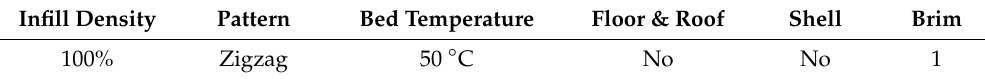
Table 3. Fixed parameters of carbon fiber-reinforced 3D printing tensile specimen.